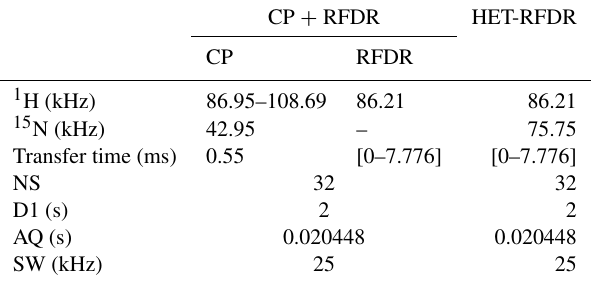
Table 1. Summary of the experimental parameters used in the 1D CP + RFDR (the start and the end values are shown) and HET- RFDR using α -PET-labeled SH3.